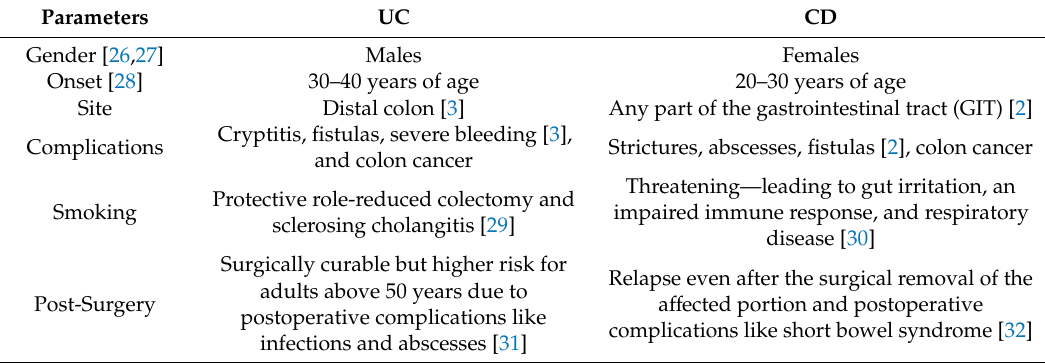
Table 1. Comparison between Crohn’s disease (CD) and ulcerative colitis (UC). Parameters UC CD Gender [26,27]